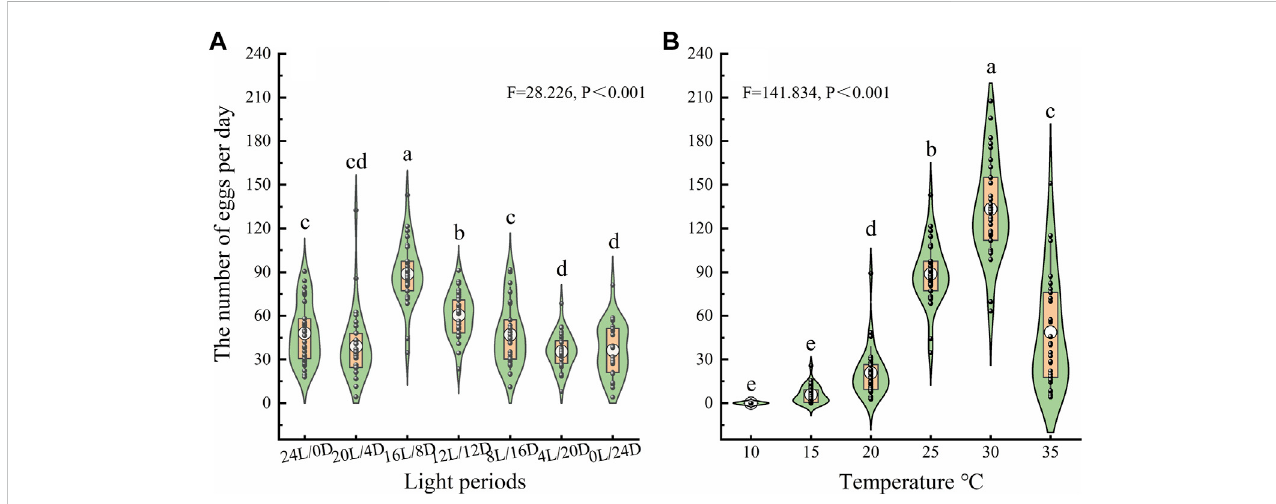
Figure 5 Number of eggs laid byovipositing femalesunder different LDcycles (A) and temperatures (B) . The lower and upper vertex of lines within the violin plots and the lines of the lower and upper edges of the box indicate the 10%, 90%, 25% and 75%, respectively; the middle circles in the boxes indicate the mean numberofeggslaid.a,b,andcindicateasigni fi cantdifferenceinthenumberofeggslaidamongdifferentconditionsaccordingtoDuncan ’ sposthoctestand one-way analysis of variance ( α =